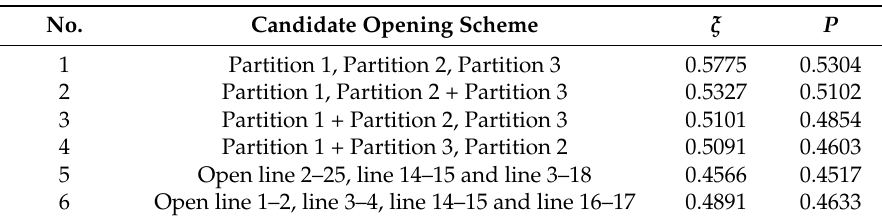
Figure 4. Basic partitions of New England 39-bus system. Table 2. Filtering Index and Priority Index of Candidate Schemes.